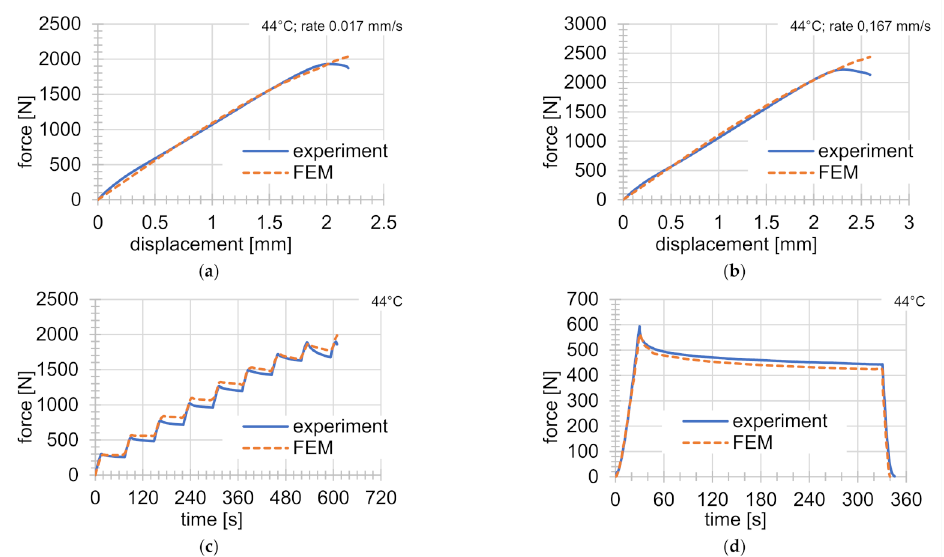
Figure 6. Comparison of FEM solutions with validation experiments at 44 ◦ C: ( a ) simple tensile test at rate of deformation of 0.017 mm s − 1 ; ( b ) simple tensile test at rate of deformation of 0.167 mm s − 1 ; ( c ) graded tensile test; ( d ) indentation